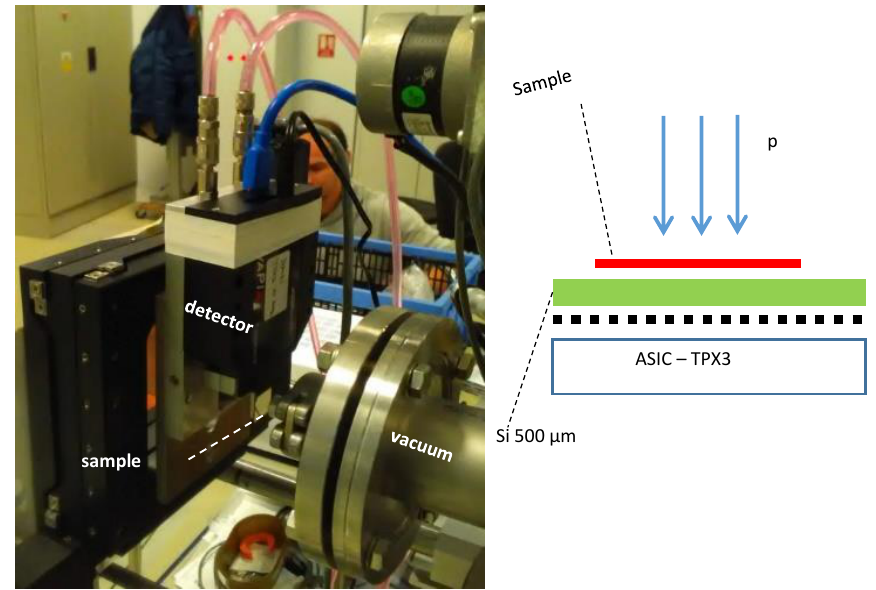
Fig. 1. Photo (left) and scheme (right) of the imaging setup in air. The detector is placed at a distance of 7 mm from the accelerator beam nozzle. The deposited energy and position of the transmitted protons are registered in high-resolution by a Timepix3 detector with a 500 µm silicon sensor (shown in